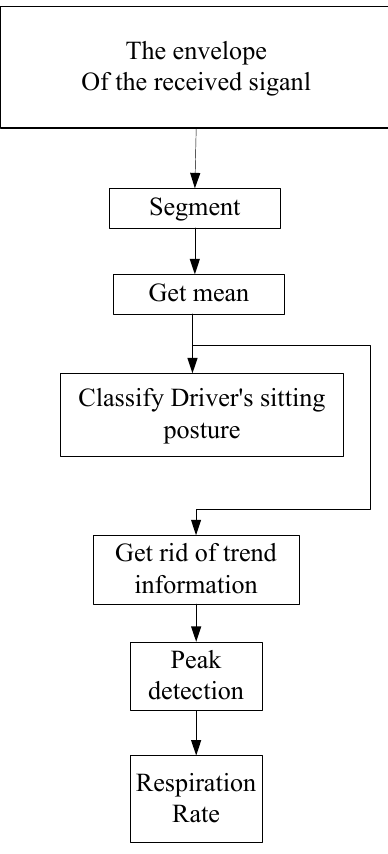
Figure 13. The Arduino flow chart.